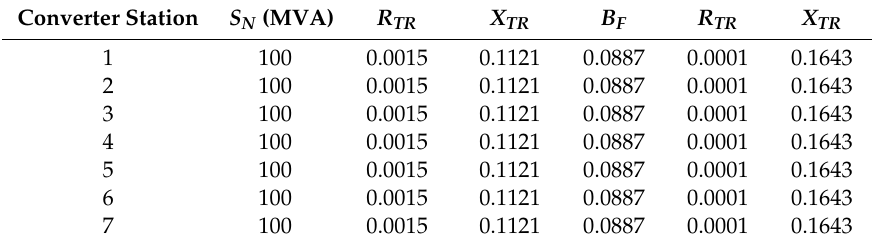
Table A30. Parameters of the converter stations in per-unit.